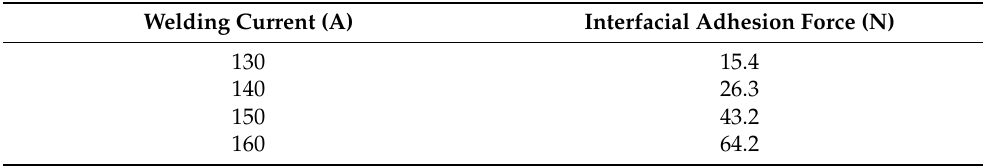
Table A3. Interfacial adhesion force between the Cu substrate and Cu35Ni25Co25Cr15 HEA coatings deposited under different welding currents.